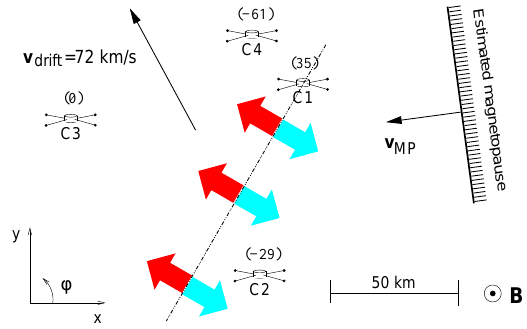
Fig. 5. A suggested thin sheet of wave generation is presented (the dashed-dotted line) in the actual geometry of this event. The lo- cation of the spacecraft, as well as the magnetopause normal and plasma drift velocity, is presented in the magnetic field oriented system used throughout the paper. The numbers in brackets are the spacecraft distances in the direction parallel to B 0 to the reference satellite